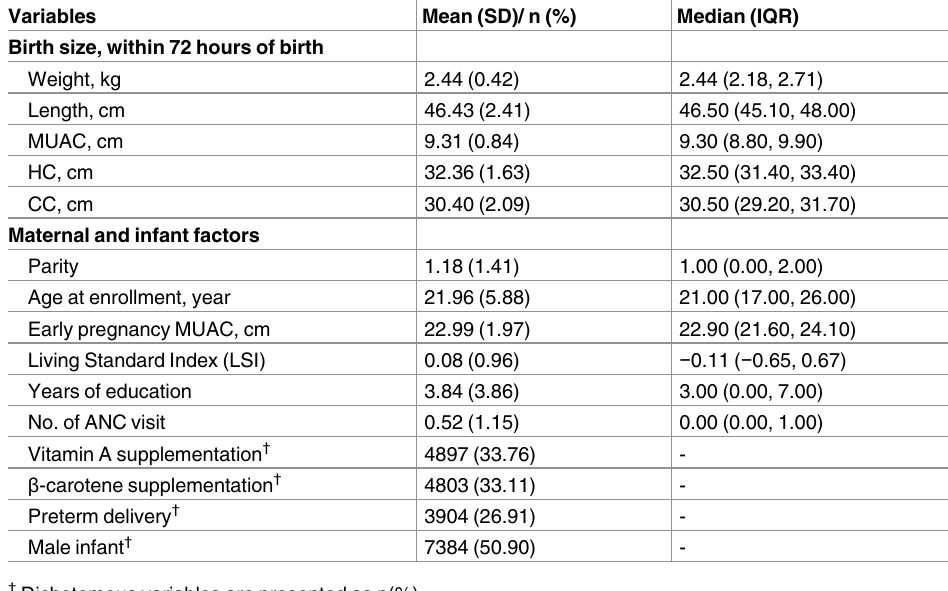
Table 1. Descriptive statistics for birth size and maternal socio-demographic factors from rural North West Bangladesh in 2002–2007,n =